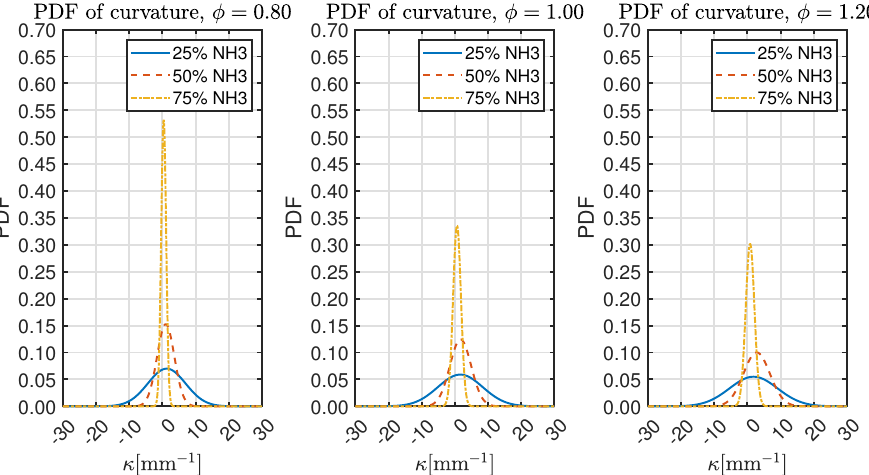
Figure 3. Probability density functions of curvature on the flame surface (isotherms at laminar inner layer